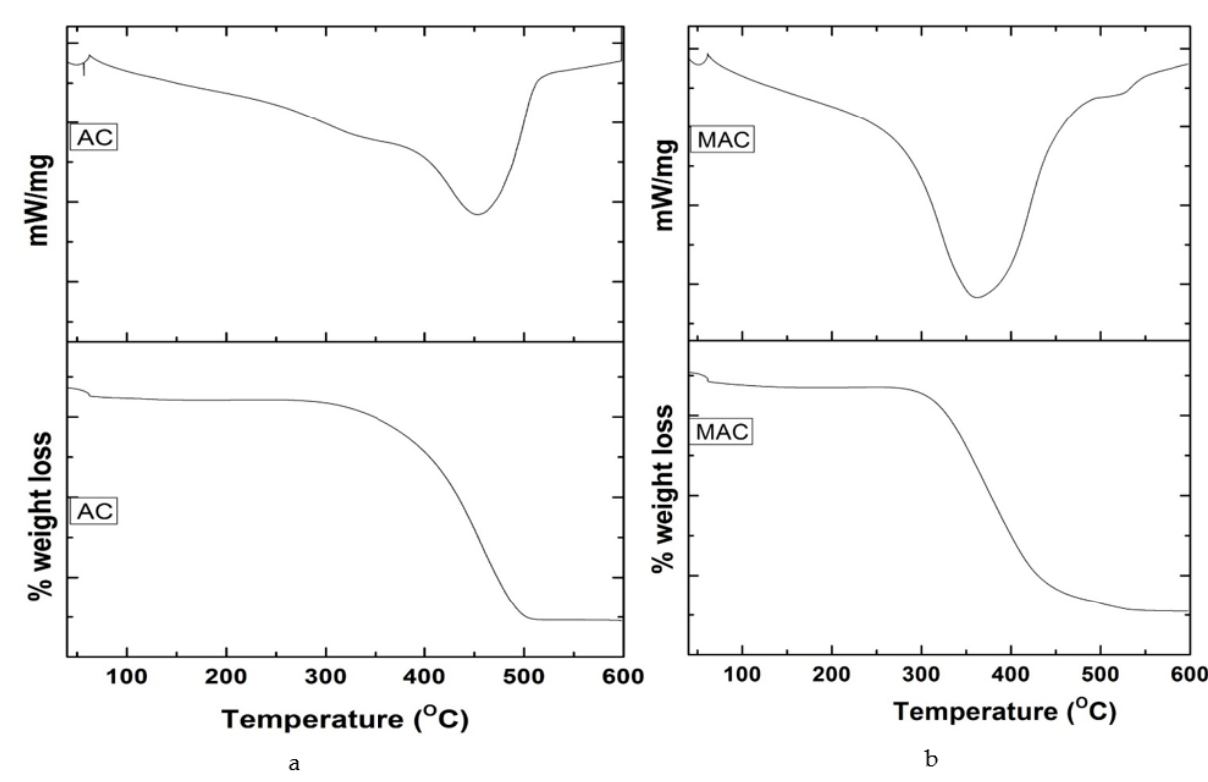
Figure 7. TG/DTA analysis of ( a ) AC and ( b ) MAC.